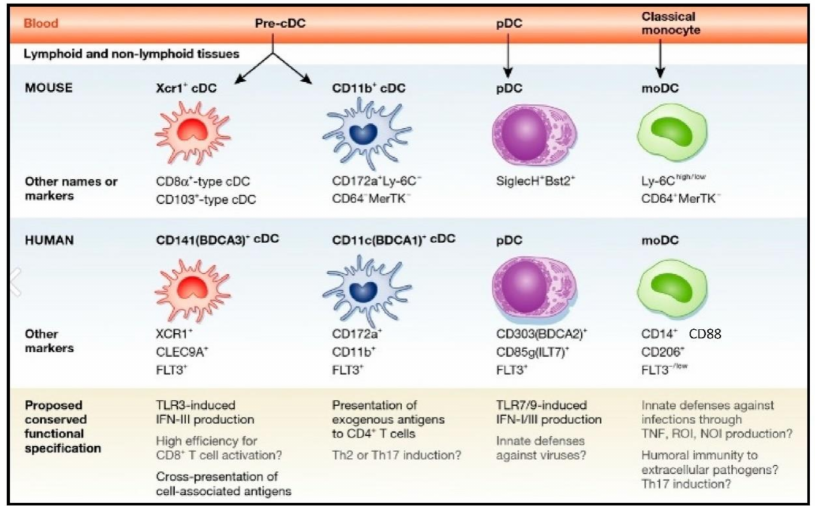
Figure 1. The major DC subsets in human and mouse. Each subset is characterized by specific surface markers and functional specification. Reproduced with permission from [15]. Copyright 2014, EMBO